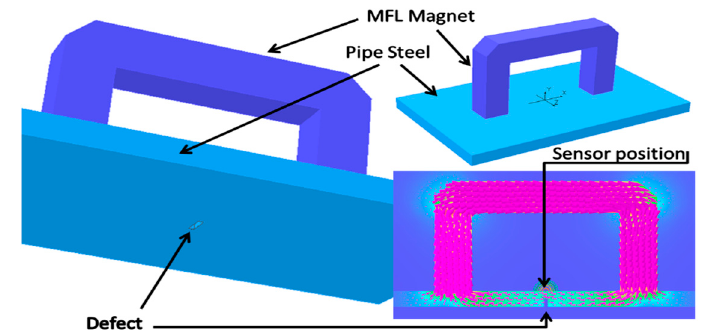
Figure 1. Basic principle of MFL inspection.